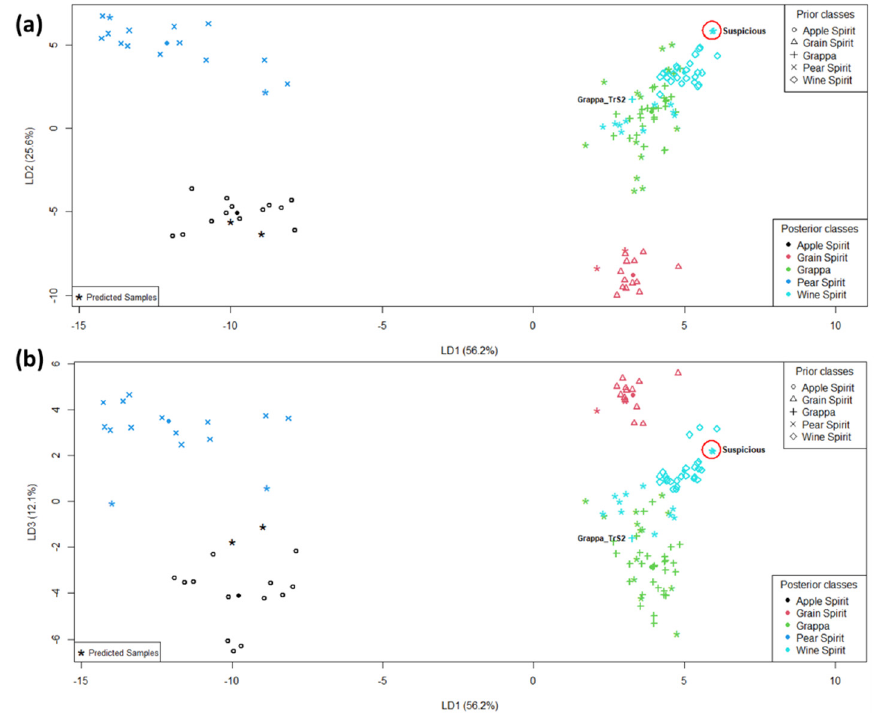
Figure 2. LDA discriminant plot, ( a ) LD1 vs. LD2; ( b ) LD1 vs. LD3. Symbols represent true classes and colors represent CV-predicted classes. Asterisks indicate projected TeS samples. Full dots ( ● ) represent class-centroids. The red circle indicates the two suspicious samples (almost totally over- lapped).